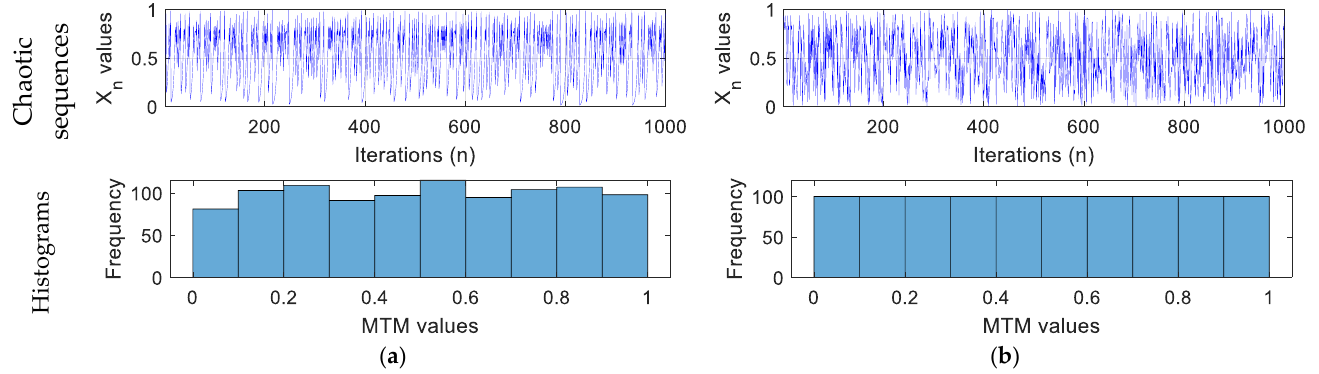
Figure 7. ( a ) Original chaotic sequence produced via MTM with ( λ 1 , λ 2 , λ 3 , λ 4 , λ 5 , λ 6 , α , X 0 ) = (cid:0) 6,1,7,3,1,9,10 − 2 ,0.5 and its ( b ) equalized histogram version generated by MTM and Algorithm 1.